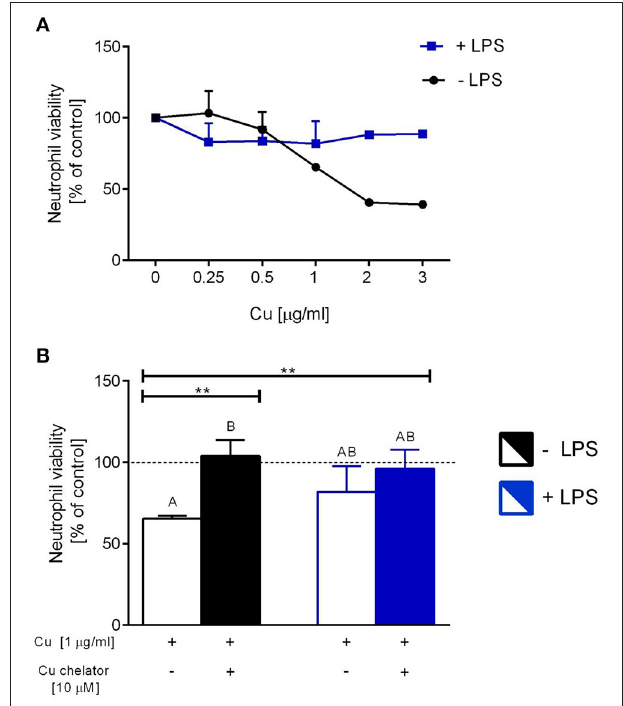
FIGURE 8 | The impact of exogenous copper of neutrophil viability (A) , and counteraction of copper effects by its chelating agent (B) in ex vivo conditions. Neutrophils isolated from the bone marrow of C57Bl/6J mice were incubated with various copper concentrations in the presence ( + LPS) or absence (–LPS) of lipopolysaccharide (A) . Cell viability reversed by the Cu chelator (B) . The dotted line (B) indicates values for untreated neutrophils (Cu concentration “0” in A ). Asterisks indicate significant differences using unpaired two-tailed Student’s t test (** P ≤ 0.01) and one-way ANOVA ( post hoc Bonferroni) test (different letters indicate statistically significant differences between